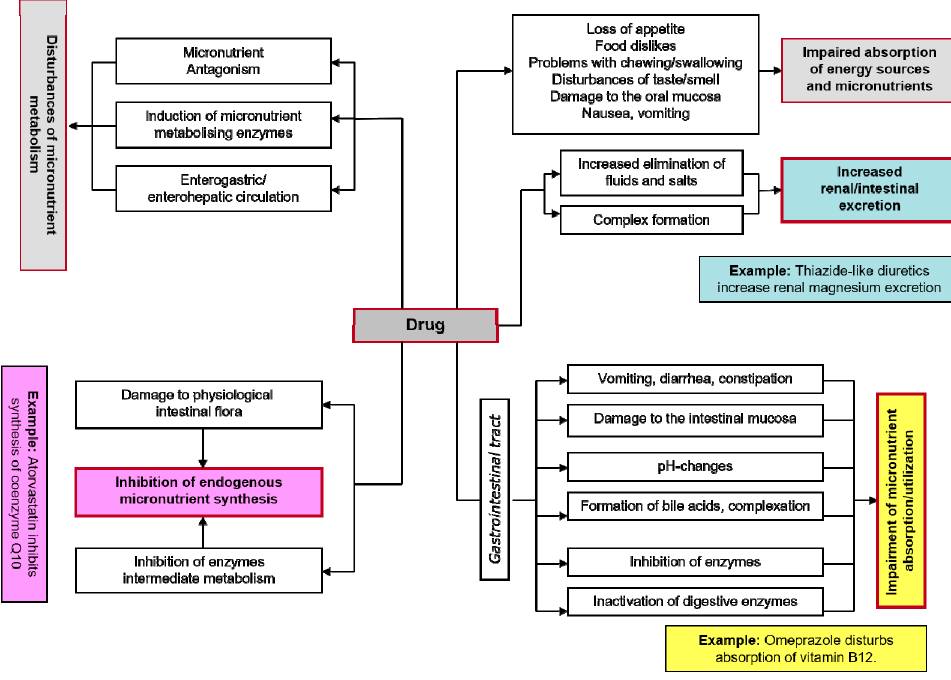
Figure 1. Disruption of micronutrient status by drugs [9,10].